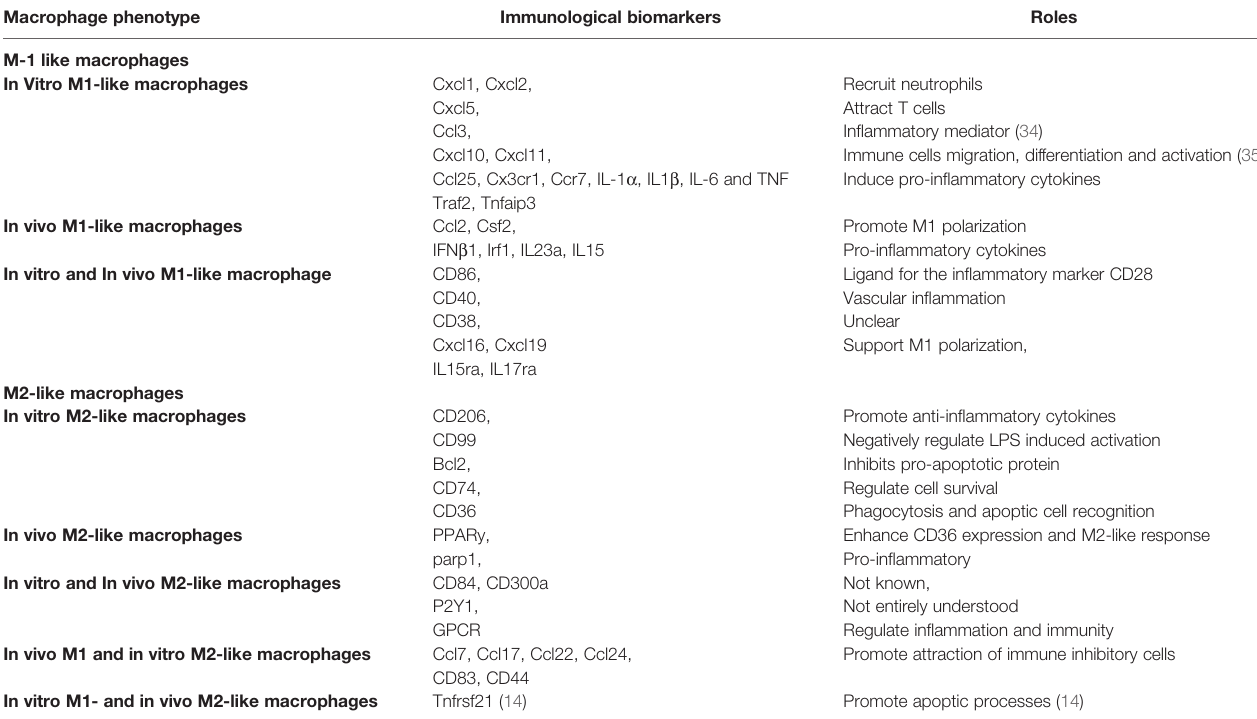
TABLE 1 | In Vivo/in Vitro macrophage markers and their corresponding